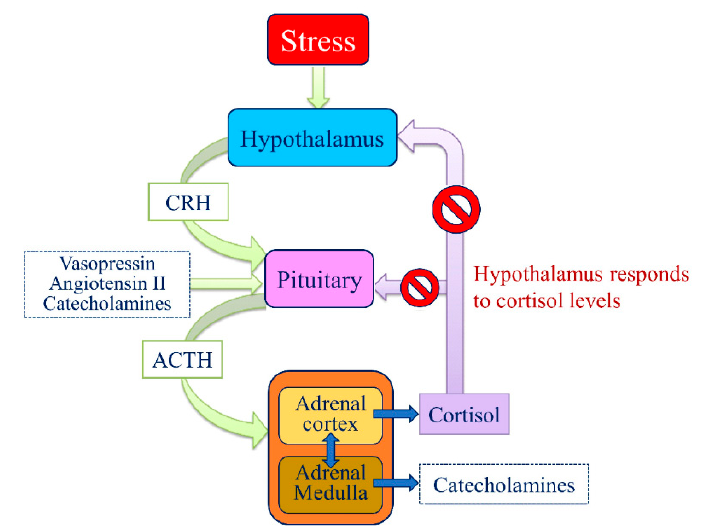
Figure 9. Schematic overview of the hypothalamic-pituitary-adrenal (HPA) axis. Stress activates the secretion into the portal circulation of the corticotropin-releasing hormone (CRH) and other ACTH secretagogues (e.g., vasopressin) then, ACTH stimulates the adrenal glands to synthesize and releases norepinephrine and glucocorticoids, primarily cortisol. Glucocorticoids, in turn, act back on the hypothalamus and pituitary (to suppress CRH and ACTH production) in a negative feedback cycle.